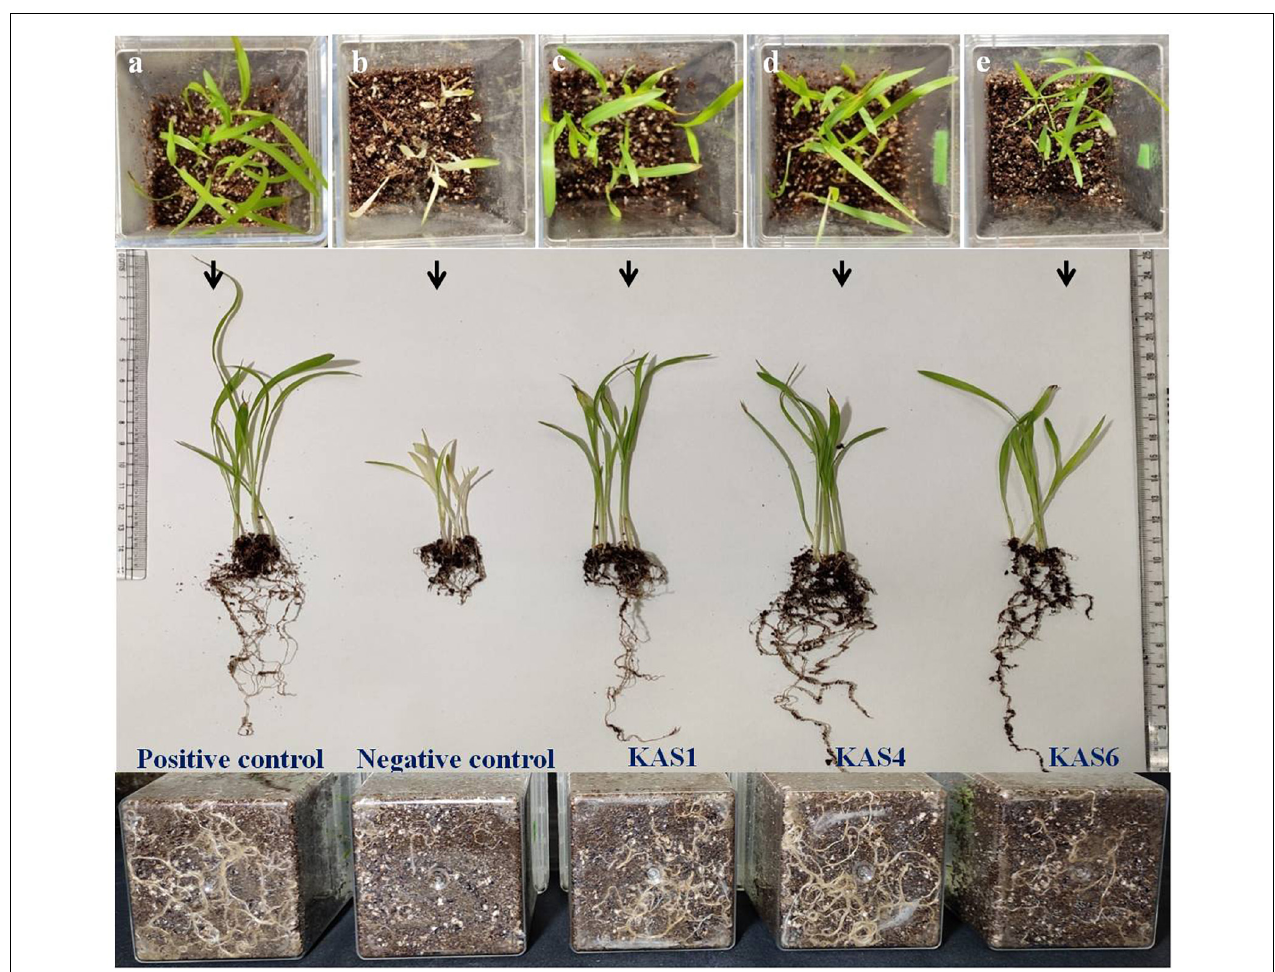
FIGURE 1 | Effect of disinfection and re-inoculation of seed endophytic bacteria (SEB) on seedling growth and root-shoot length (seedlings were 8 days old). (a) Positive control is where seeds were treated only with NaOCl; (b) negative control is where seeds were treated with NaOCl + antibiotic; (c–e) KAS1, KAS4, and KAS6 are where seeds initially treated NaOCl + antibiotic were inoculated with strains KAS1 ( Kosakonia cowanii ), KAS4 ( Pantoea stewartii ), and KAS6 ( Pseudomonas aeruginosa ), respectively. In the first lane: seedlings grown in magenta boxes viewed from the top; second lane: seedlings taken out from the boxes and viewed; and third lane: viewed from the back of magenta boxes showing root